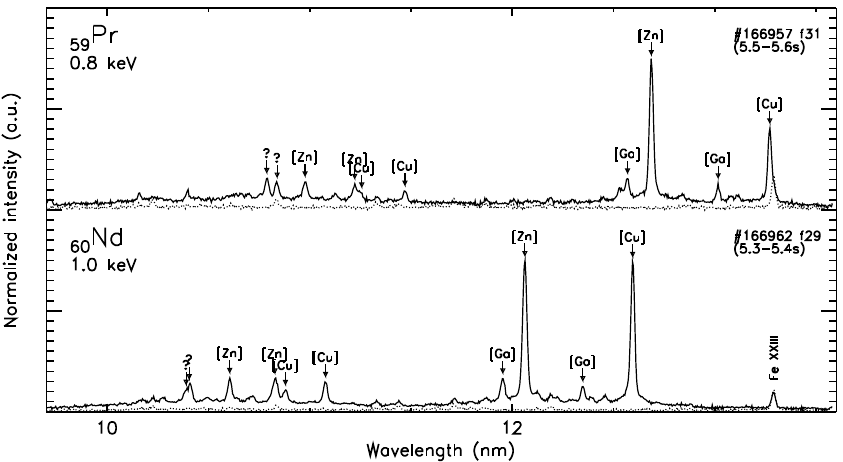
Figure 2. EUV emission spectra observed in LHD plasmas with TESPEL injections of Pr and Nd in the wavelength range of 9.7–13.6 nm. The dotted lines indicate background spectra taken before the TESPEL injection. The spectrum of each element is normalized to its maximum intensity. Isoelectric sequence of each ion is indicated by a bracket for the identified